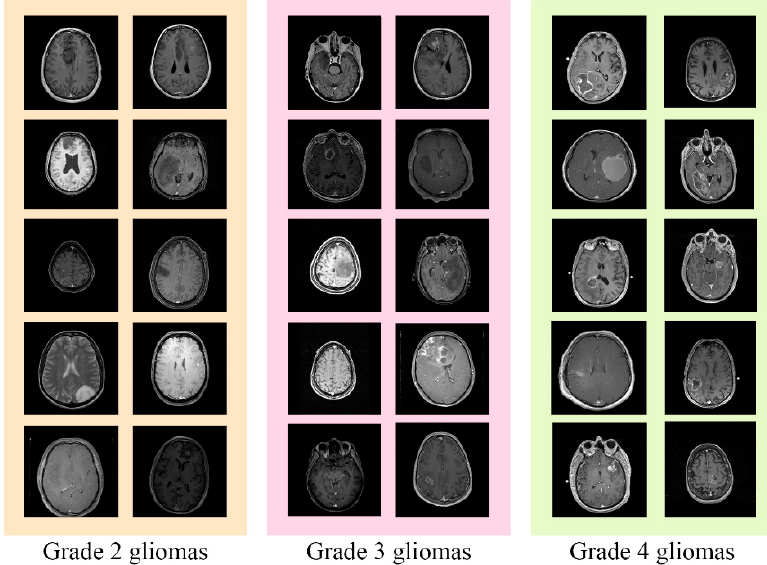
Figure 1. Gliomas of grades 2, 3, and 4 as they appeared on brain magnetic resonance images.